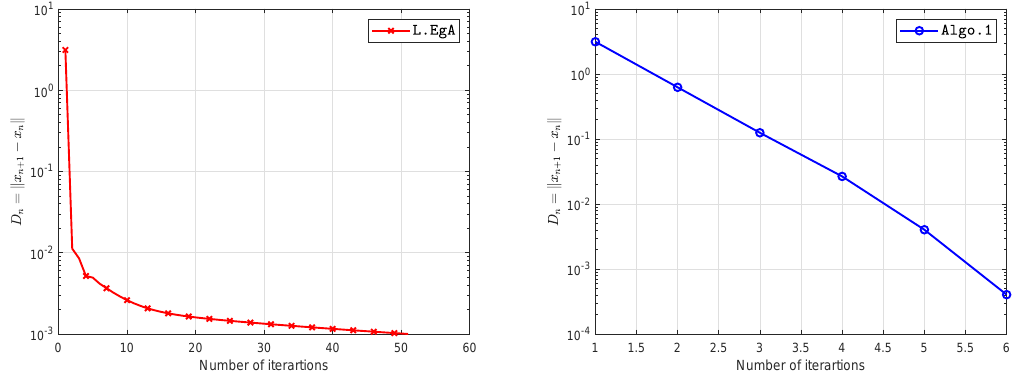
Figure 6. Example 2 for average number of iterations while n = 10.